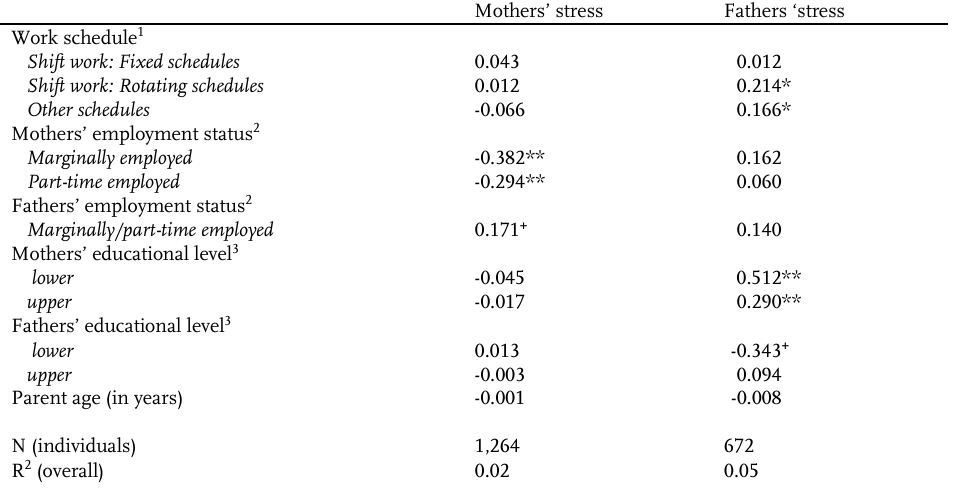
Table 2 : Effects of shift-work on mothers’ and fathers’ stress level: random-effects